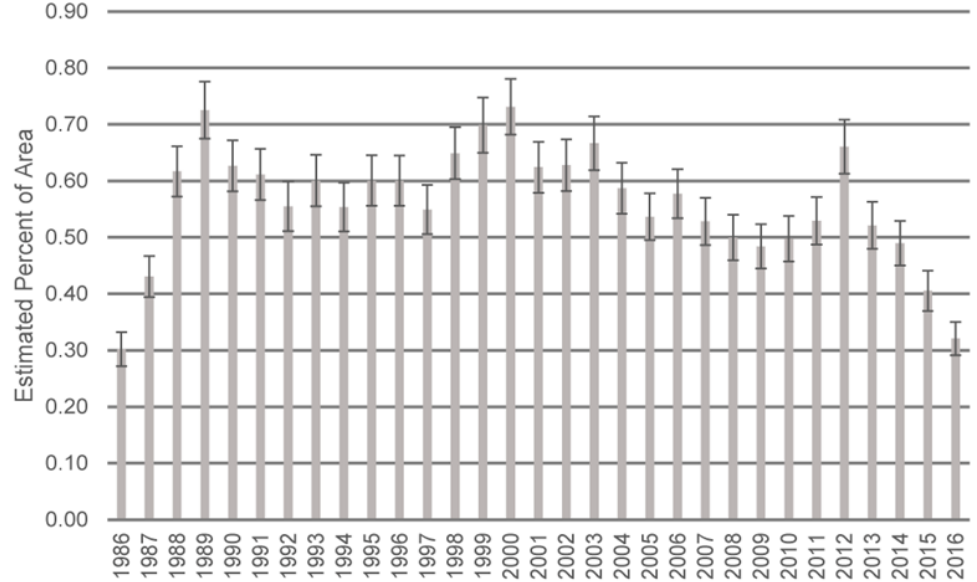
Figure 1. Annual estimated percent area of CONUS land-cover class change, 1985–2016 (error bars represent one standard error, 1986 “change year” 1 July 1985 to 30 June 1986).